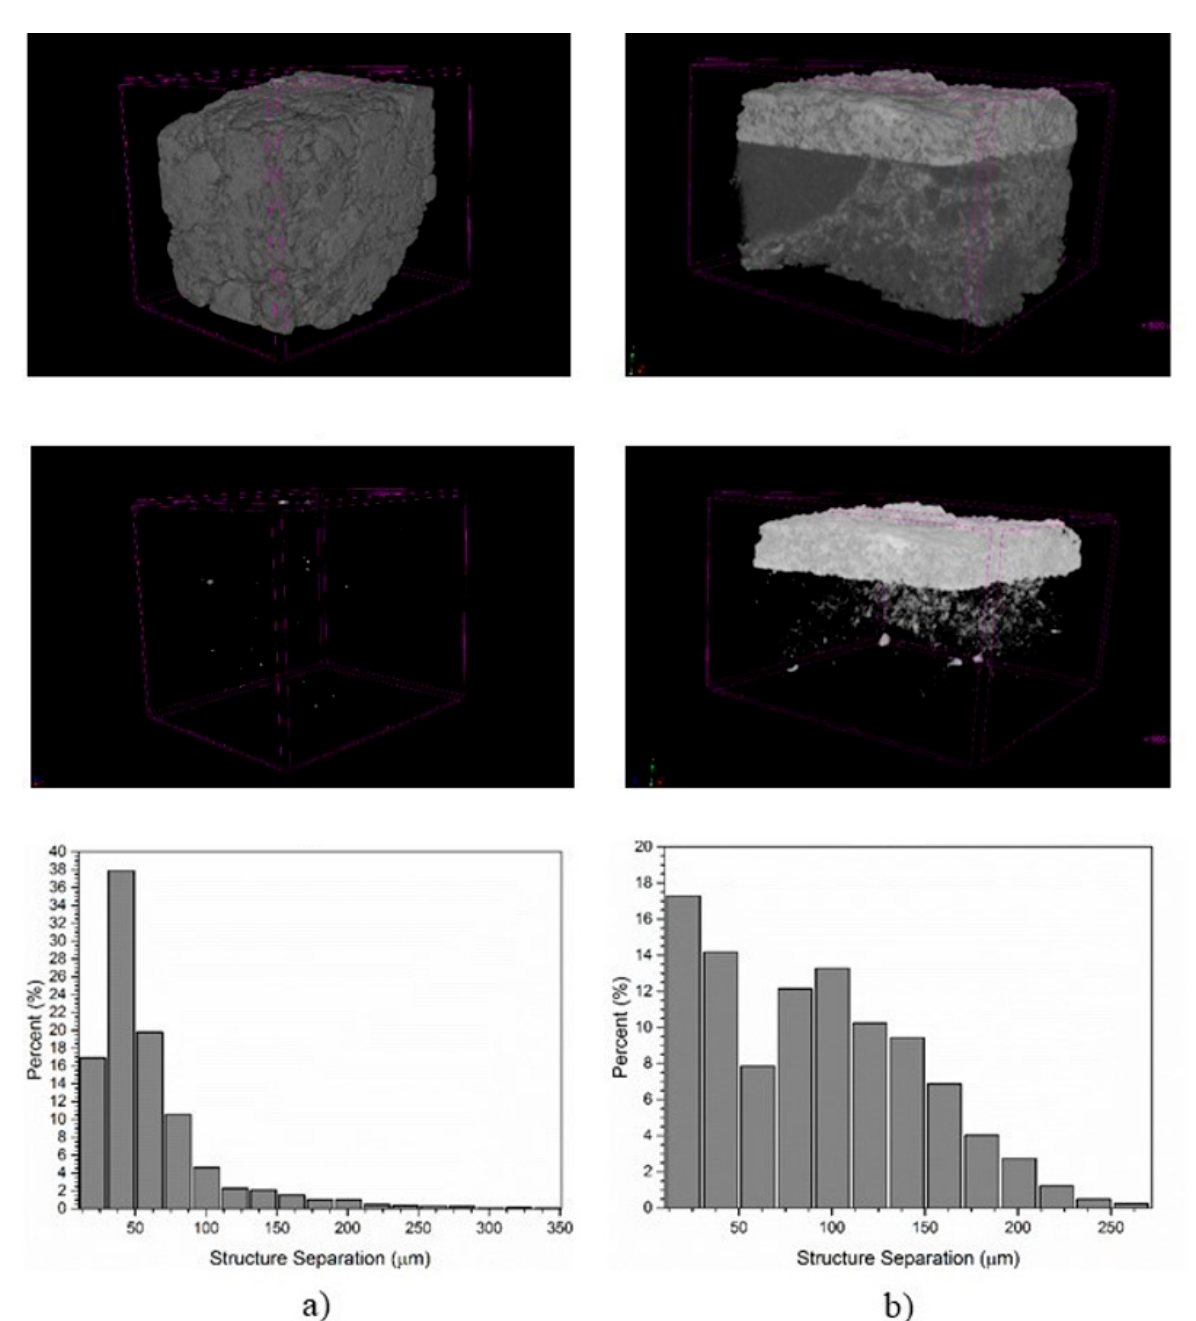
Figure 10. 3D images and pore size distribution of the brick area obtained by micro-CT of composition: ( a ) A-1 and ( b ) A-3 after the sandwich coating test.